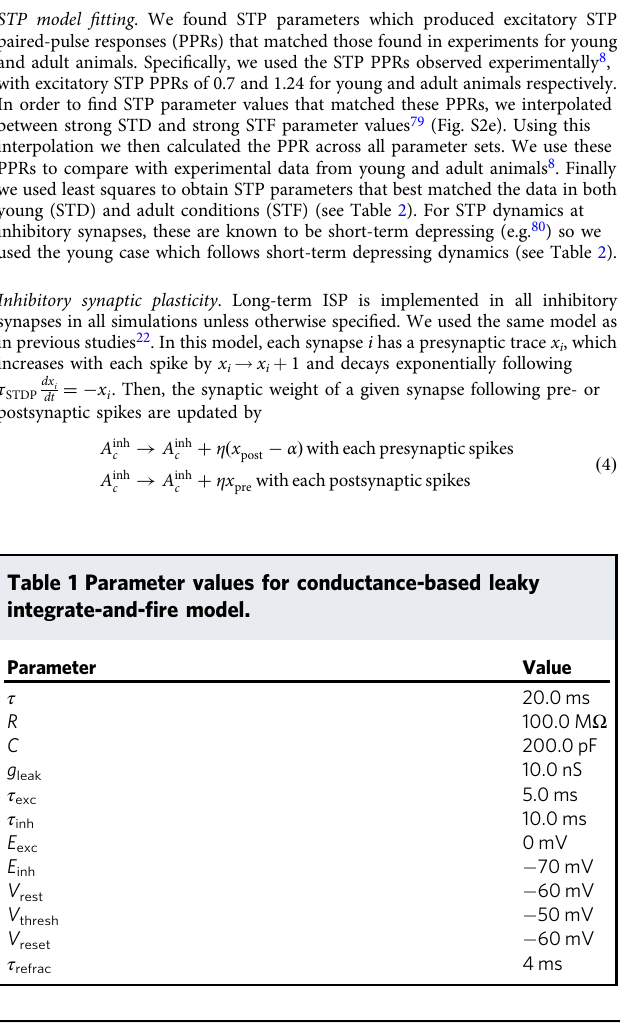
Table 2 STP parameter values.